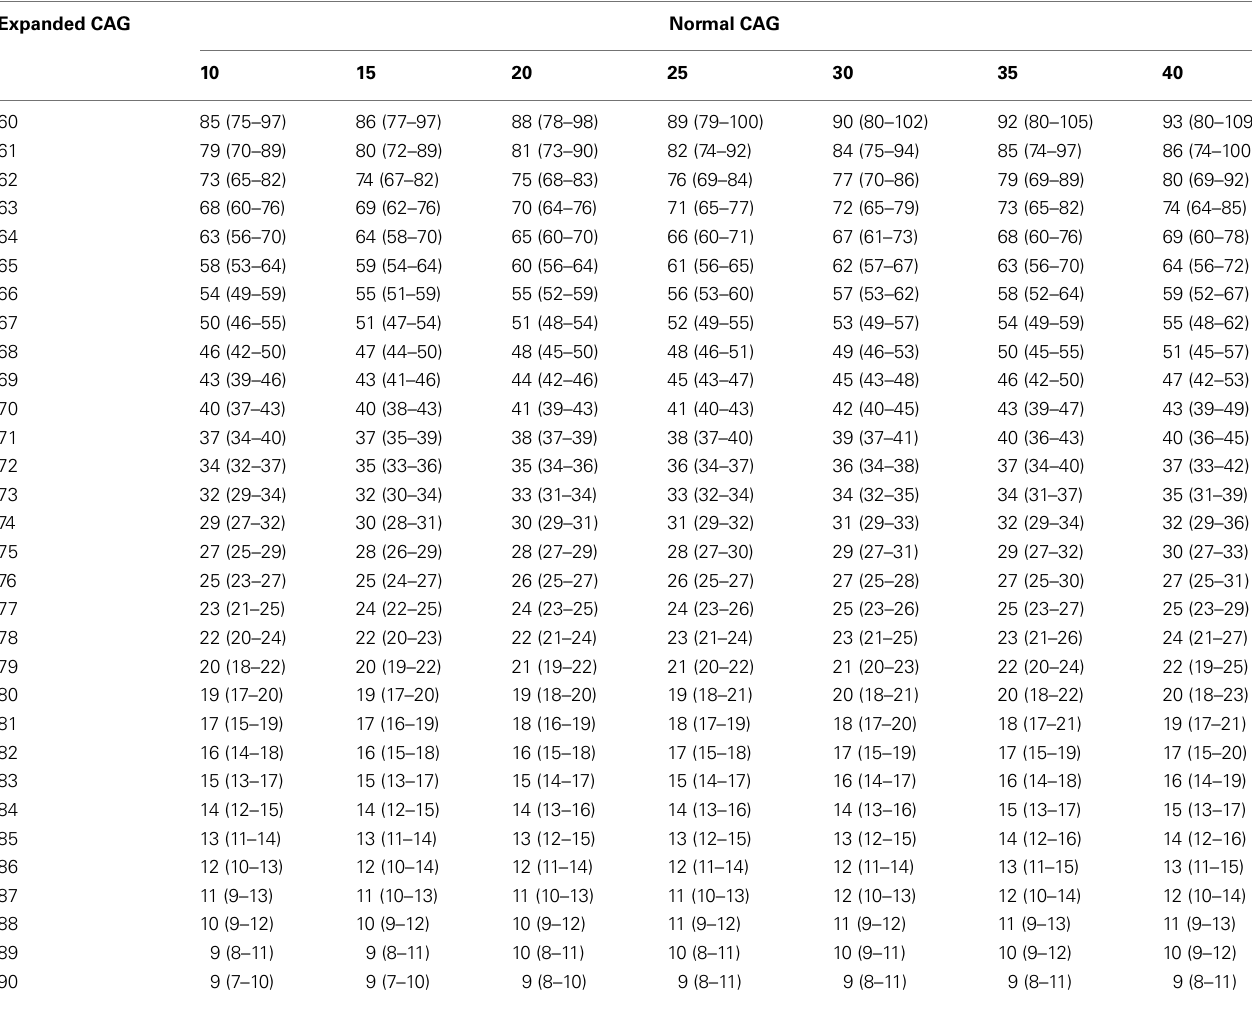
Table 4 | Predicted ages at onset for each normal (CAG 10–40 ) and expanded (CAG 60–90 ) repeat length in MJD (MLE – maximum likelihood estimation